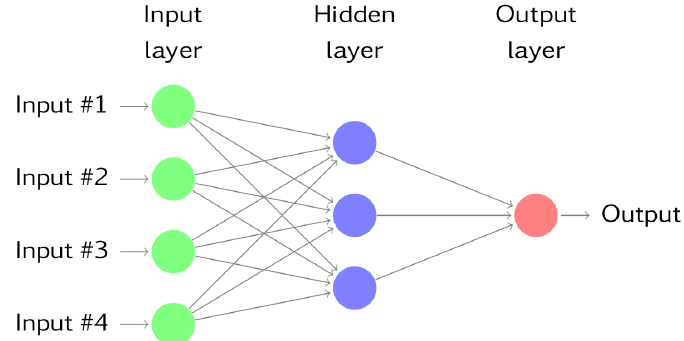
Figure 7. Neural Network with three layers, four neurons in the input